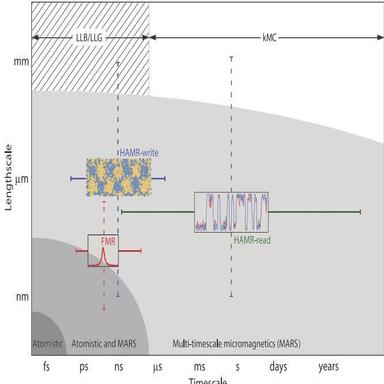
Illustration of the time/length scales required by some common simulations.